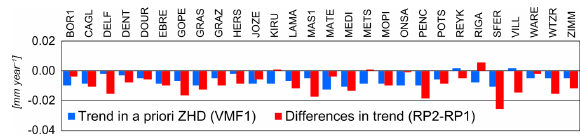
Figure 10. Differences between the values of the 18-year linear trends obtained from the Repro2 and the Repro1 campaigns, com- pared to the 18-year ZHD linear trend obtained from VMF1.